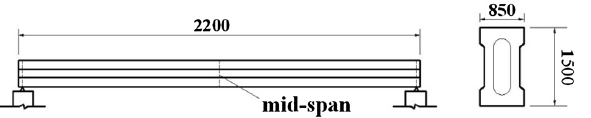
Fig. 5 Monorail track beam (unit: mm)